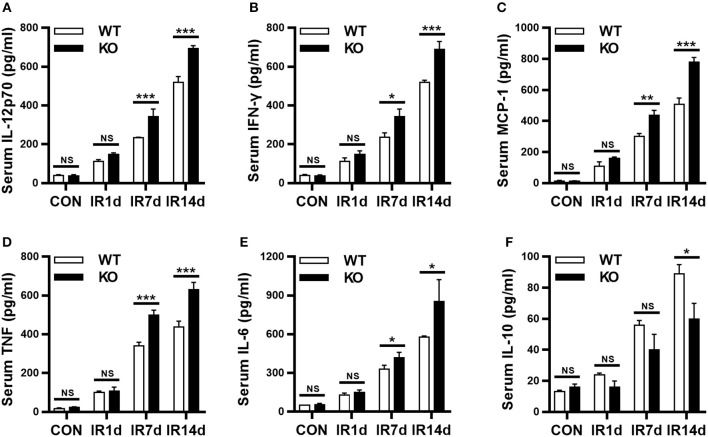
Loss of Nrf2 aggravates radiation-induced imbalance of serum inflammatory cytokines. BD CBA Mouse Inflammation Kit was used to measure the serum levels of inflammatory cytokines at different time points. Nrf2 knockout increased radiation-induced serum levels of IL-12p70 (A), IFN-γ (B), MCP-1 (C), TNF (D), and IL-6 (E). Nrf2 knockout inhibited radiation-induced serum levels of IL-10 (F). n = 6. NSRepresents no statistical difference (P > 0.05). *P < 0.05; **P < 0.01; ***P < 0.001. Every experiment was repeated for 3 times and the data was shown as mean ± SD.